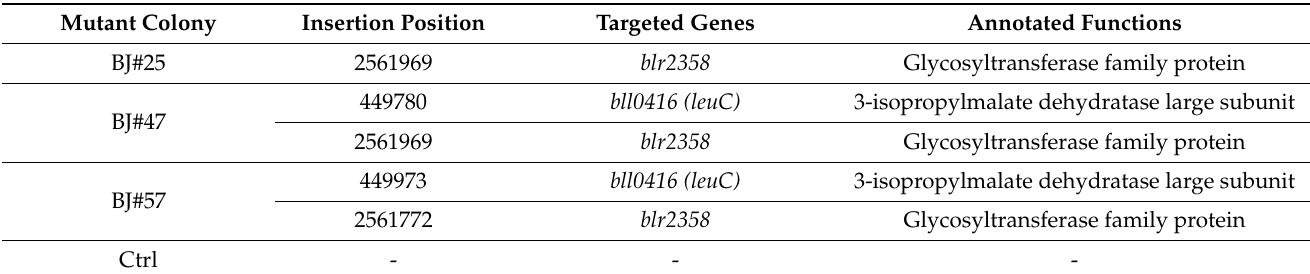
Table 1. Identification of transposon insertion sites in B. diazoefficiens USDA110 mutant colonies. Mutant